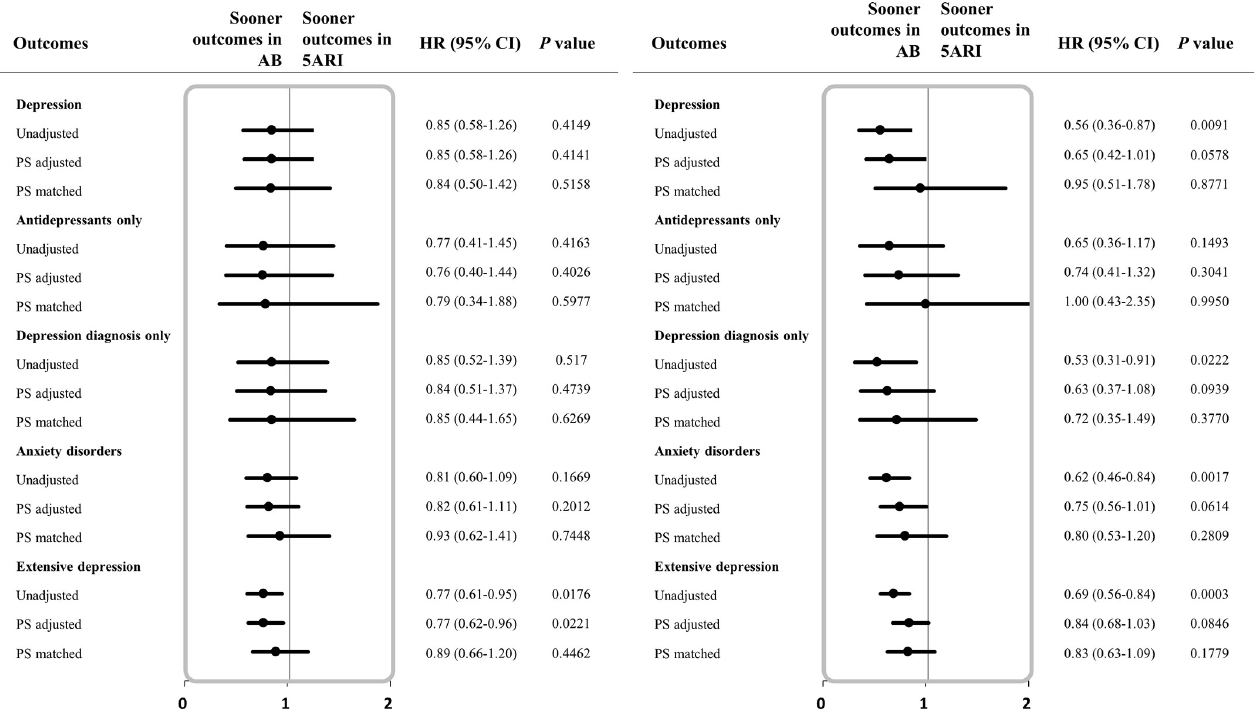
Fig 4. a. Forest plot for hazard ratio related to depressive symptoms among BPH patients exposed to 5ARI versus AB in hospital. b. Forest plot for hazard ratio related to depressive symptoms among BPH patients exposed to 5ARI versus AB in clinic. The study outcomes: depression (classified into 3 categories based on the combination of diagnosis and antidepressants), anxiety disorder, and extensive depression. Abbreviations: BPH, Benign prostatic hyperplasia; 5ARI, 5alpha reductase inhibitor; AB, alpha blocker; HR, hazard ratio; CI, confidence intervals; PS adjusted, adjusted by propensity score quintiles; PS matched, matched 1:1 by propensity